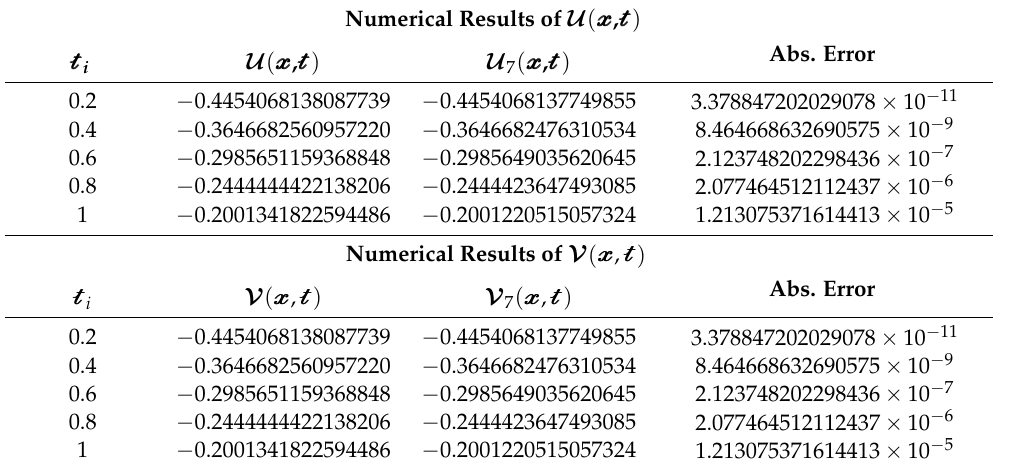
Table 2. Numerical results for Example 2 at x = 10, 𝒶 = 1, and n = 7.